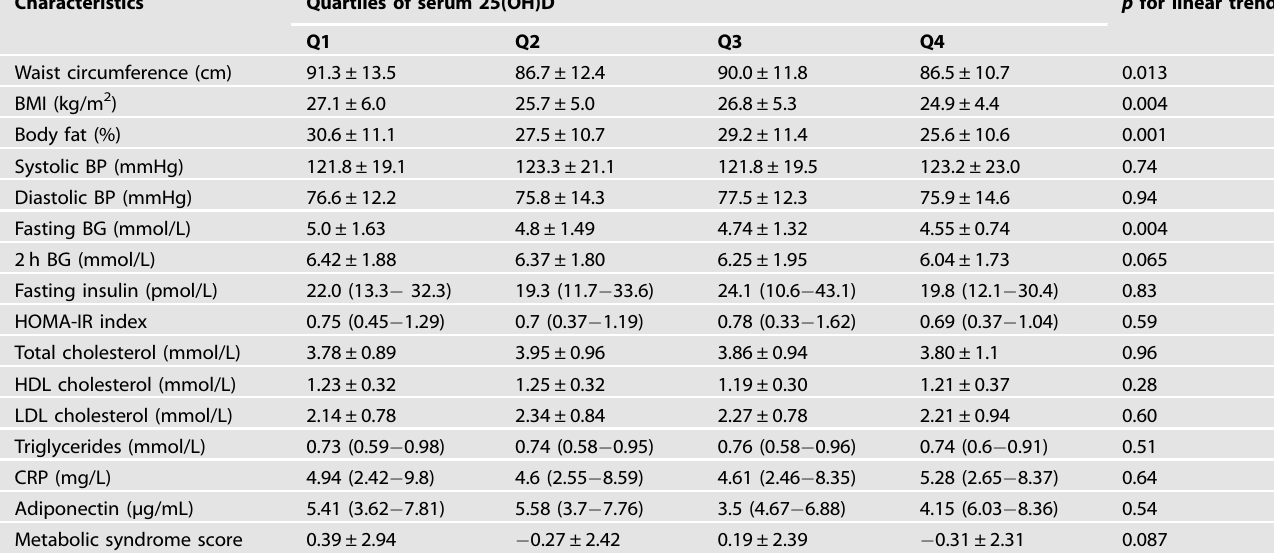
Table 2. Metabolic characteristics by quartiles of serum 25(OH)D concentrations (Cameroon study: n = 586).